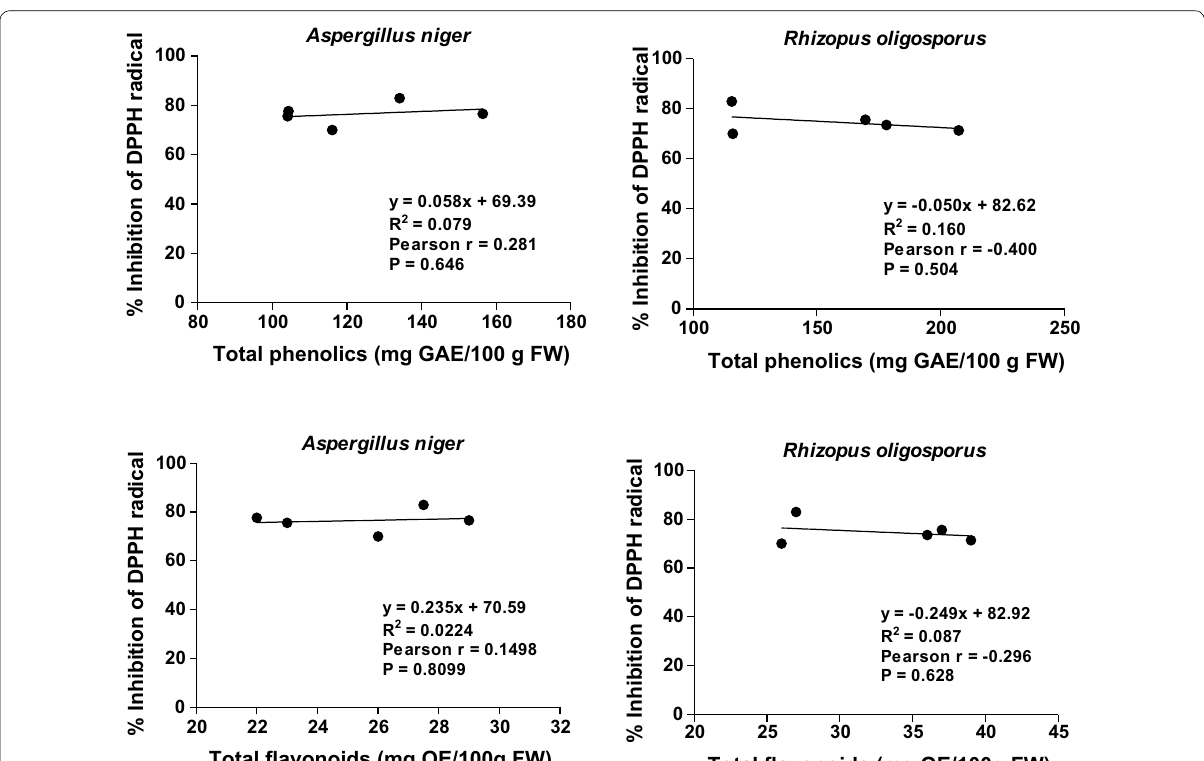
Fig. 5 Correlation coefficients between antioxidant activity (DPPH) and total phenolics and total flavonoids in the extracts of solid‑state fermented apricot press